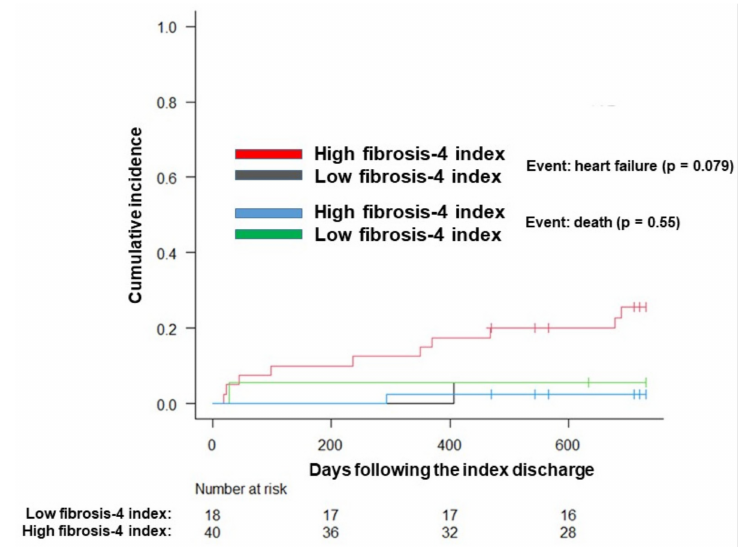
Figure 4. Cumulative incidence of the primary endpoint accounting for death as a competing risk among those with a high fibrosis-4 index at